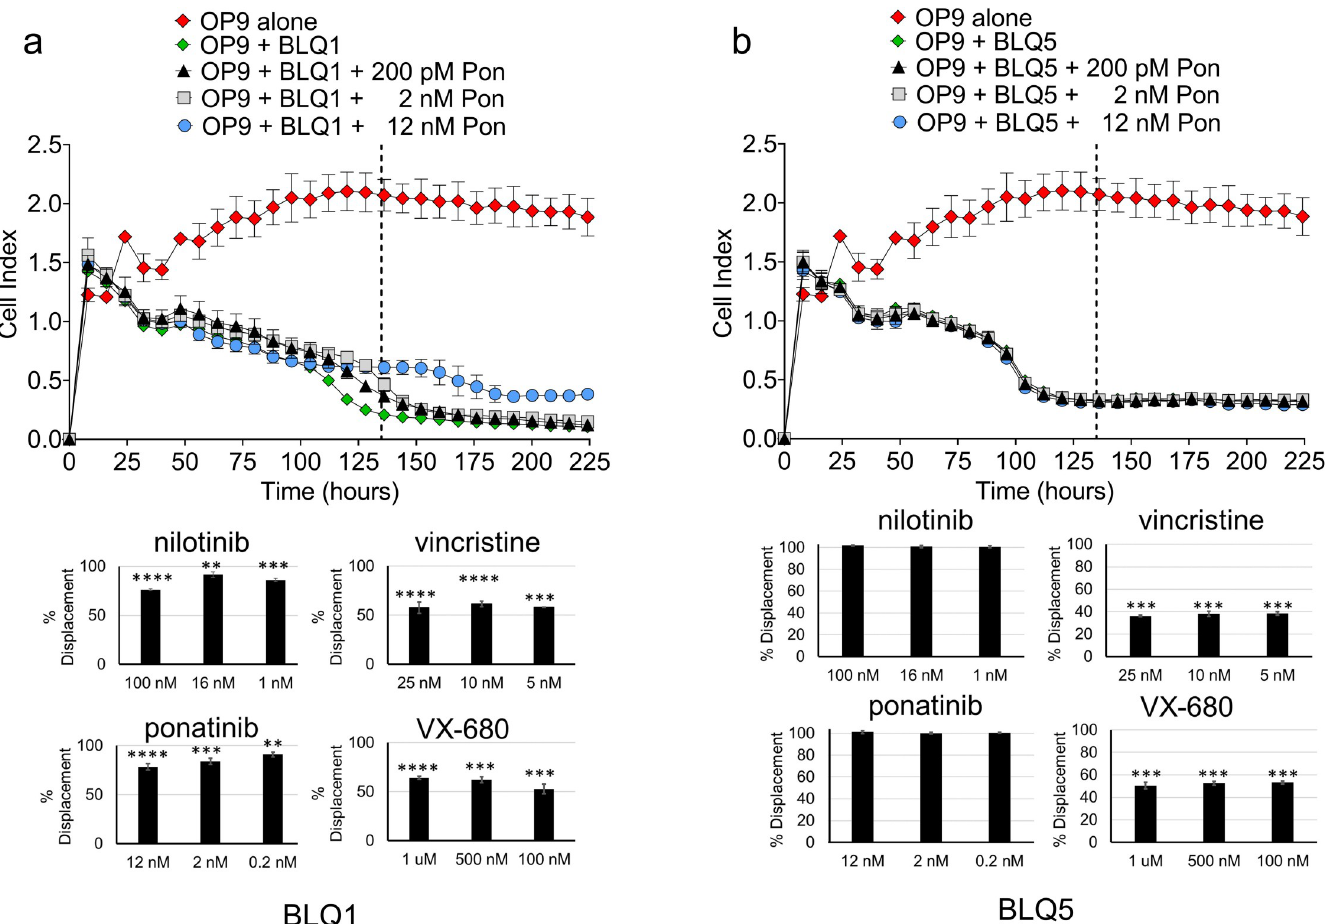
Fig 6. Different drug treatments generate unique patterns of impedance signal displacement in BCP-ALL cell co-cultures. Ph-positive BCP-ALL cells include BLQ1 (A) and BLQ5 (B) cells. Top graphs : different concentrations of ponatinib (pon). Dotted lines show the time point used for the % displacement calculation (also see S3 Fig). Bottom graphs : Percentage impedance signal displacement from treatment of BLQ1 and BLQ5 with the indicated concentrations of four drugs at the time points indicated in S3 Fig. Statistical significance was determined using one-way ANOVA, followed by followed by Dunnett’s multiple comparison test. Error bars represent standard deviation (n = 3). p values relative to control: � < 0.05; �� < 0.01; ��� < 0.001; ���� < 0.0001.